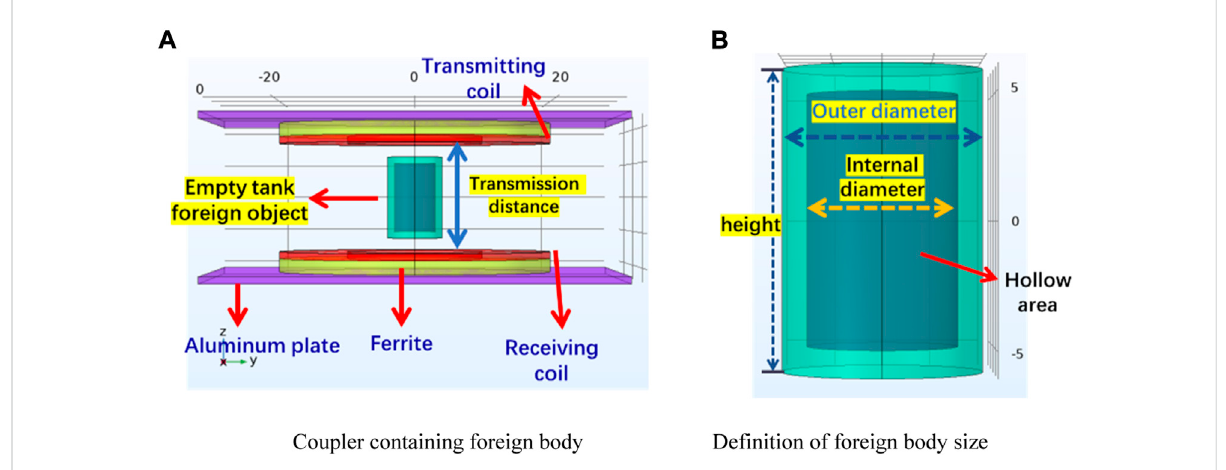
FIGURE 2 Coupler model with foreign objects. (A) Coupler containing a foreign body. (B) De fi nition of foreign body